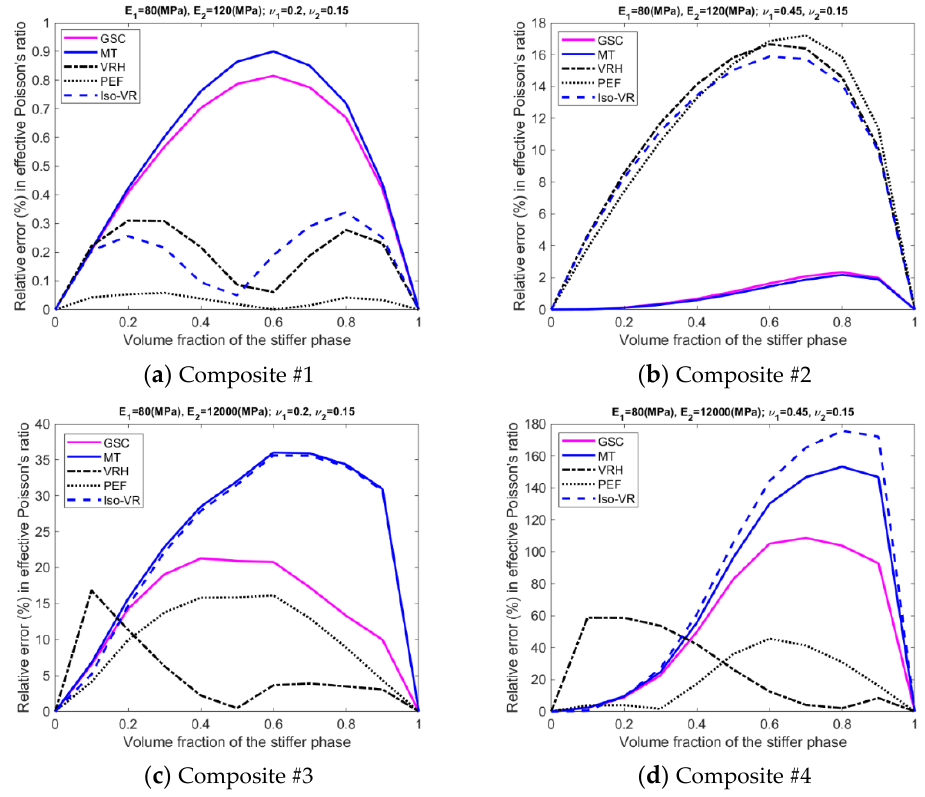
Figure A8. Relative error in effective Poisson’s ratio.